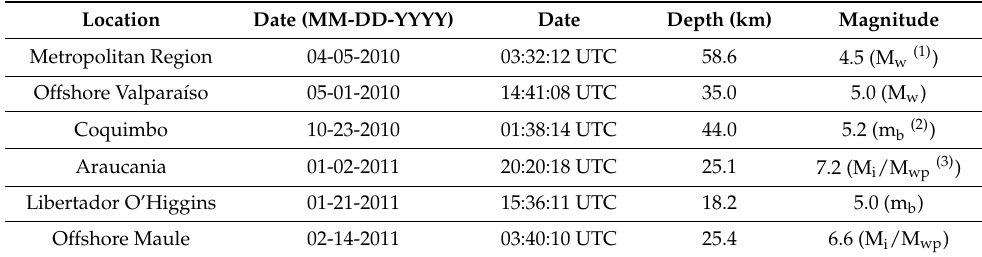
Table 1. List of seismic events recorded in the building (source: